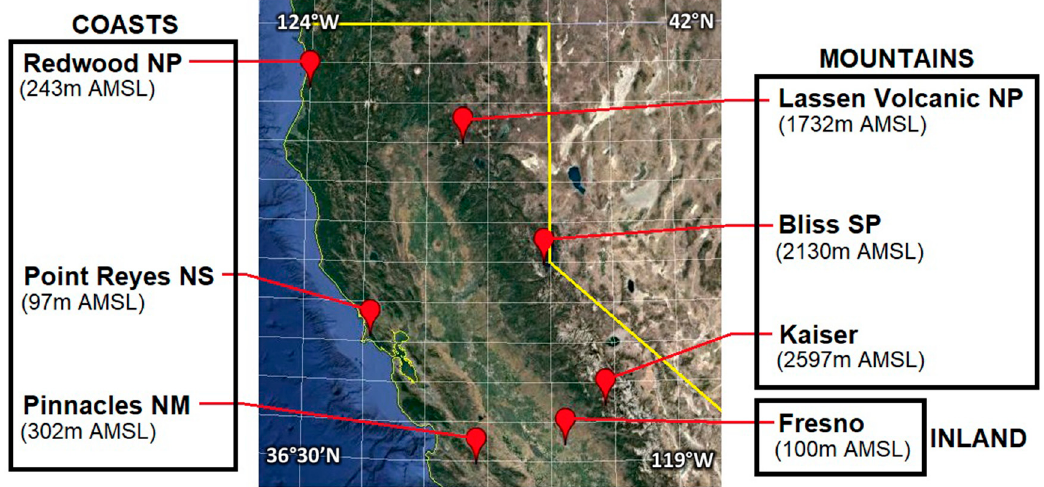
Figure 5. The seven observational sites used in the study were taken to represent data at coastal (Redwood NP, Point Reyes NS, and Pinnacles NM), inland (Fresno), and mountainous (Lassen Volcanic NP, Bliss SP, and Kaiser) regions. Elevation was recorded in units of meters above mean sea level.